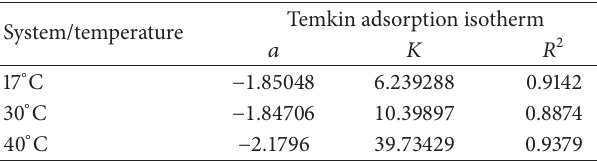
Table 3: Temkin isotherm parameters at 17, 30, and 40 ∘ C for mild steel in 1MHCl with GA.